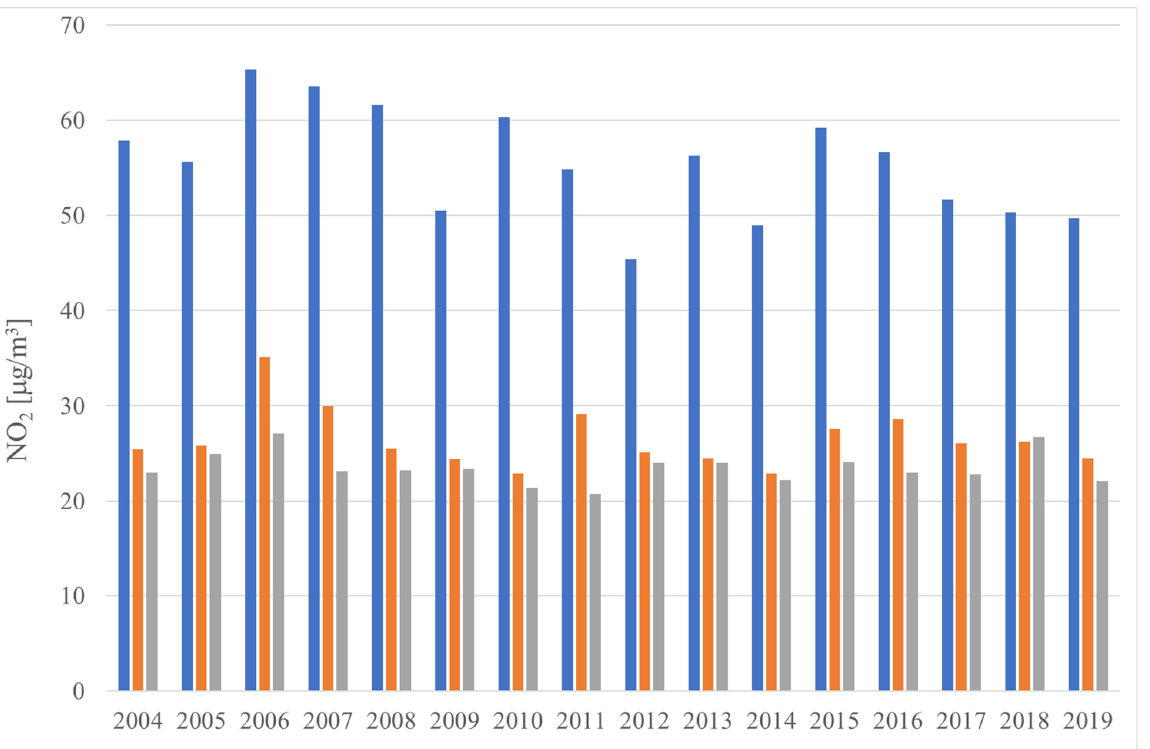
Figure 4. Annual concentrations of NO 2 in Warsaw 2004–2019. Measuring stations: blue bar–Al. Niepodleg ł o ś ci (traffic station), orange bar–Targówek (urban background station), grey bar–Ursynów (urban background station) (developed by the author on the basis of GIO Ś data).